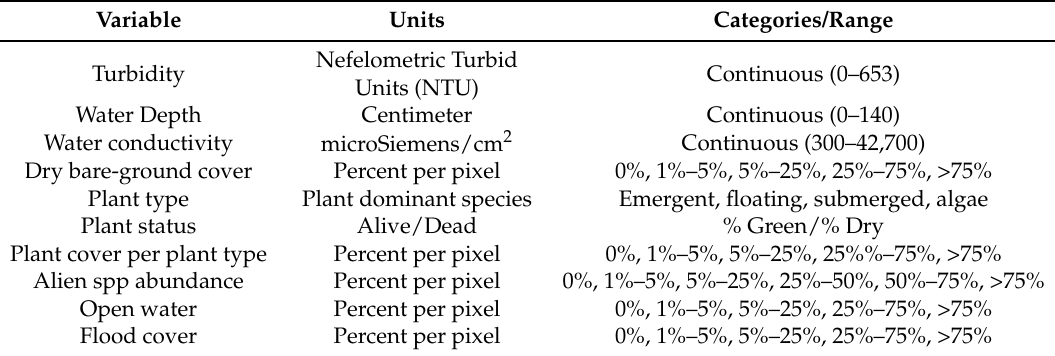
Figure 2. Different flooding features in Doñana marshes showing the spatio-temporal variability found in these wetlands. The flooded picture shows the shallow inundation with variable plant cover and turbidity. Table 1. Ground-truth points collected variables with their corresponding units and categories.